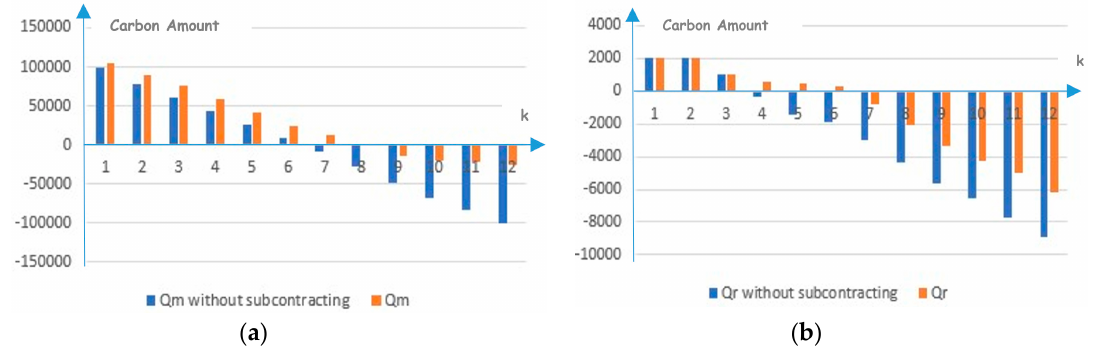
Figure 5. Amount of emitted carbon with and without subcontracting unit. ( a ) Manufacturing unit; ( b ) Remanufacturing unit.